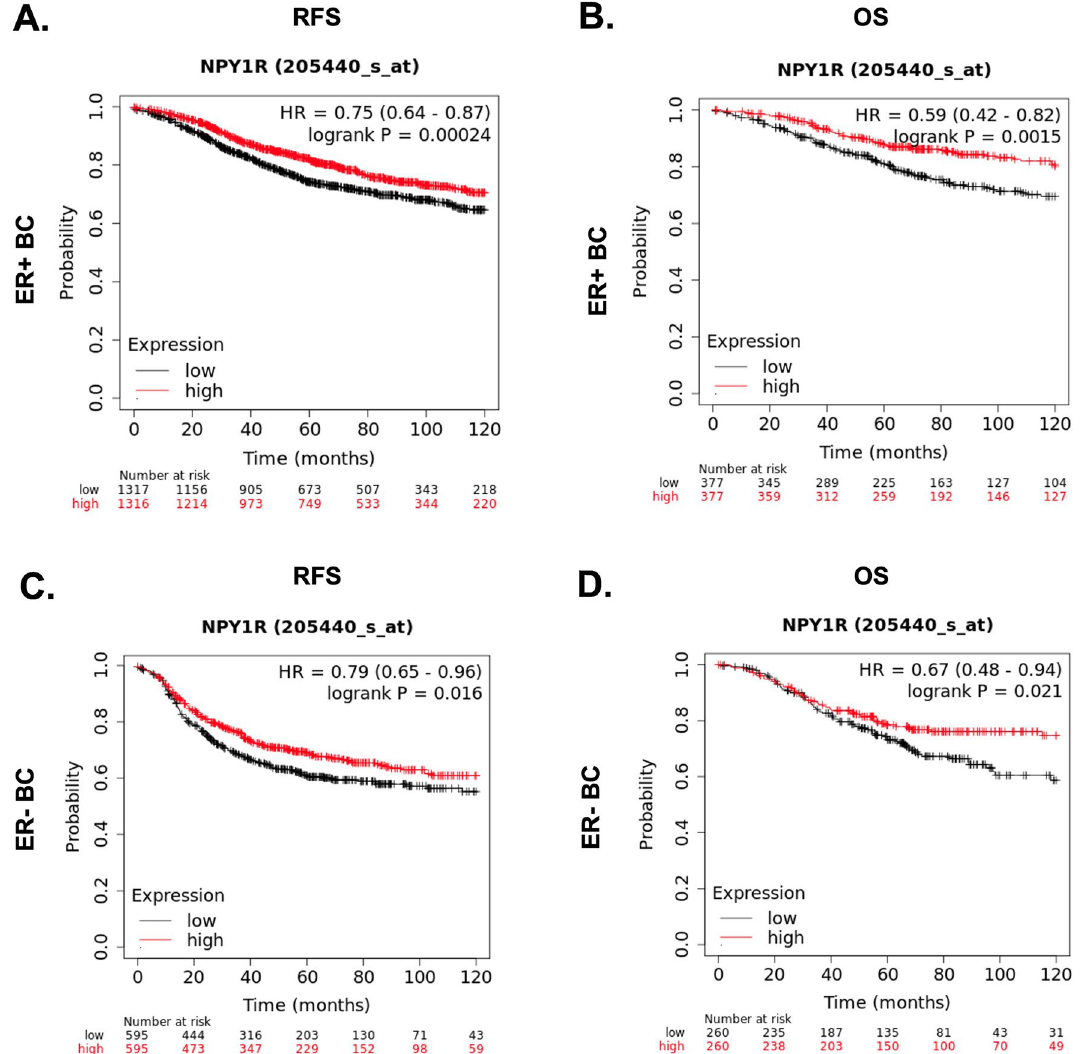
Figure 6. NPY1R expression predicts better relapse-free survival (RFS) and overall survival (OS) in ER+ BC patients. The impact of NPY1R expression on RFS ( A , C ) and OS ( B , D ) in ER+ ( A , B ) and ER− ( C , D ) BC patients was plotted using KMplotter, which assessed the effects of 22,277 genes on survival in 2422 BC patients. Red line: higher than median NPY1R expression; black line: lower than median NPY1R expression. HR hazard ratio. Log-rank P-value of < 0.05 was considered statistically